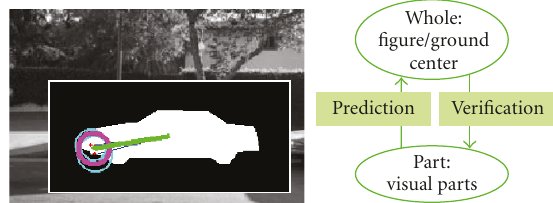
Figure 6: Part to whole prediction and whole to part verification in part-whole context.